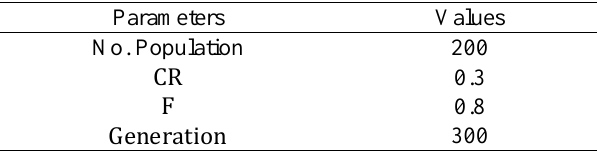
Table 11. Parameters setting for SAICA algorithm .